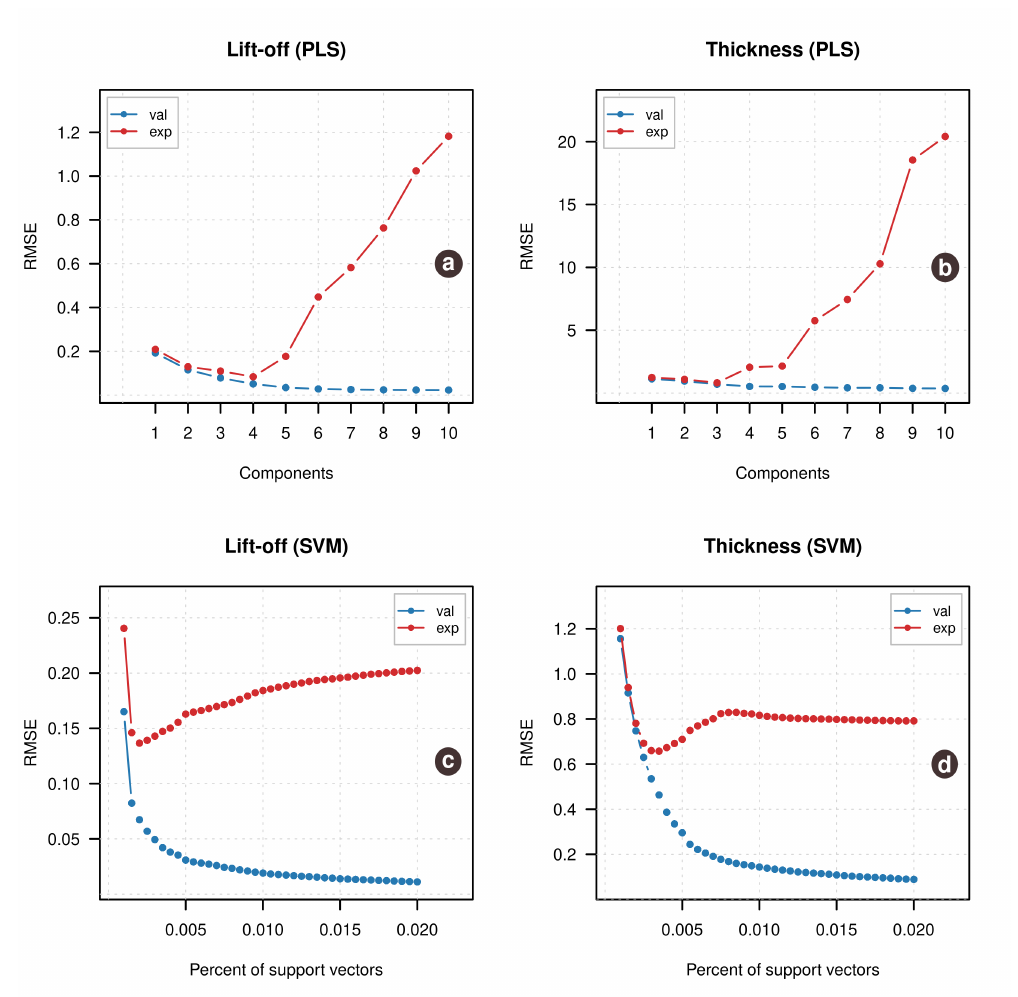
Figure 6. Root mean squared error (RMSE) vs. number of components plots for the Partial Least Squares (PLS) regression models (( a ) — for prediction of lift-off, ( b ) — for prediction of thickness) and RMSE vs. ν -values for the Support Vector Machine (SVM) regression models (( c ) — for prediction of lift-off, ( d ) — for prediction of thickness). The blue points show developing of RMSE for the simulated validation set, the red points show RMSE values for the experimental